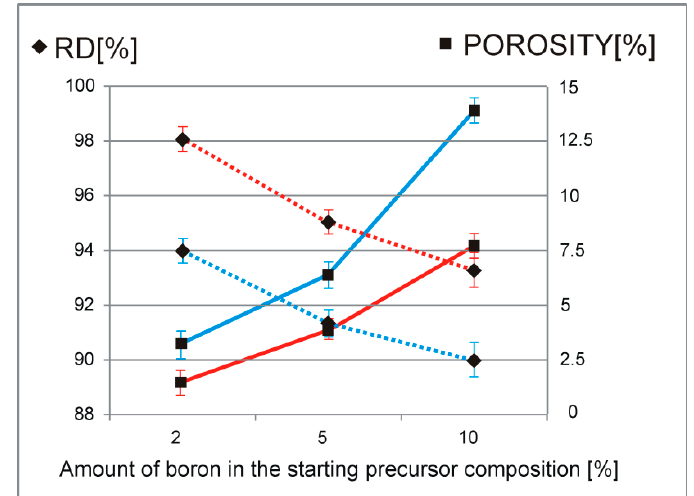
Figure 8. Relative density (RD–dotted lines) and porosity (full lines) analysis of the obtained composite sinters for different PPS temperature regimes (blue—900 °C, red—1100 °C) and ranges of the starting precursor compositions (2%, 5%, 10%).